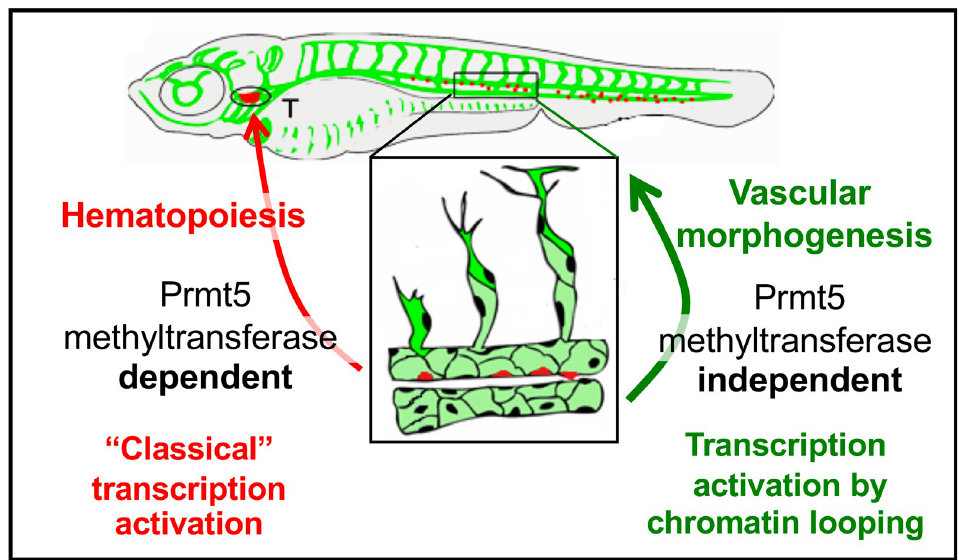
Fig 6. Schematic representation of the two distinct roles of Prmt5 during the formation of hematopoietic lineages and blood vessels, relying or not on its methyltransferase activity, respectively.